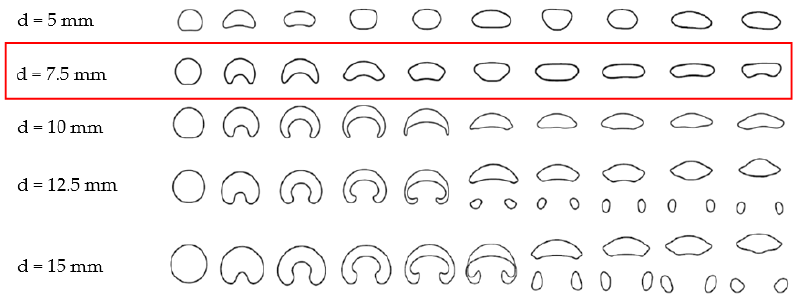
Figure 4. The change curve of bubble position with time under different grid numbers: ( a ) Top ( b ) Bottom.